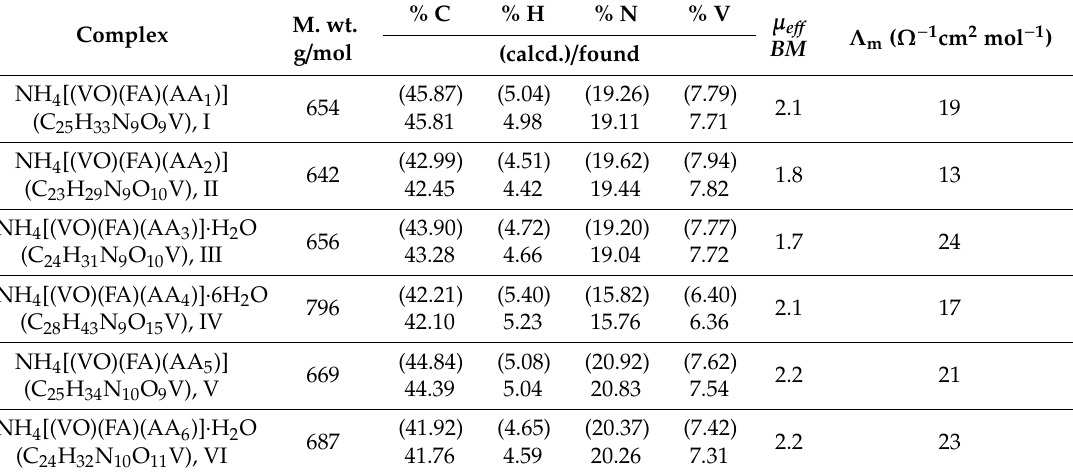
Table 1. Elemental analysis and physical data of NH 4 [(VO)(FA)(AA n )] complexes. Complex